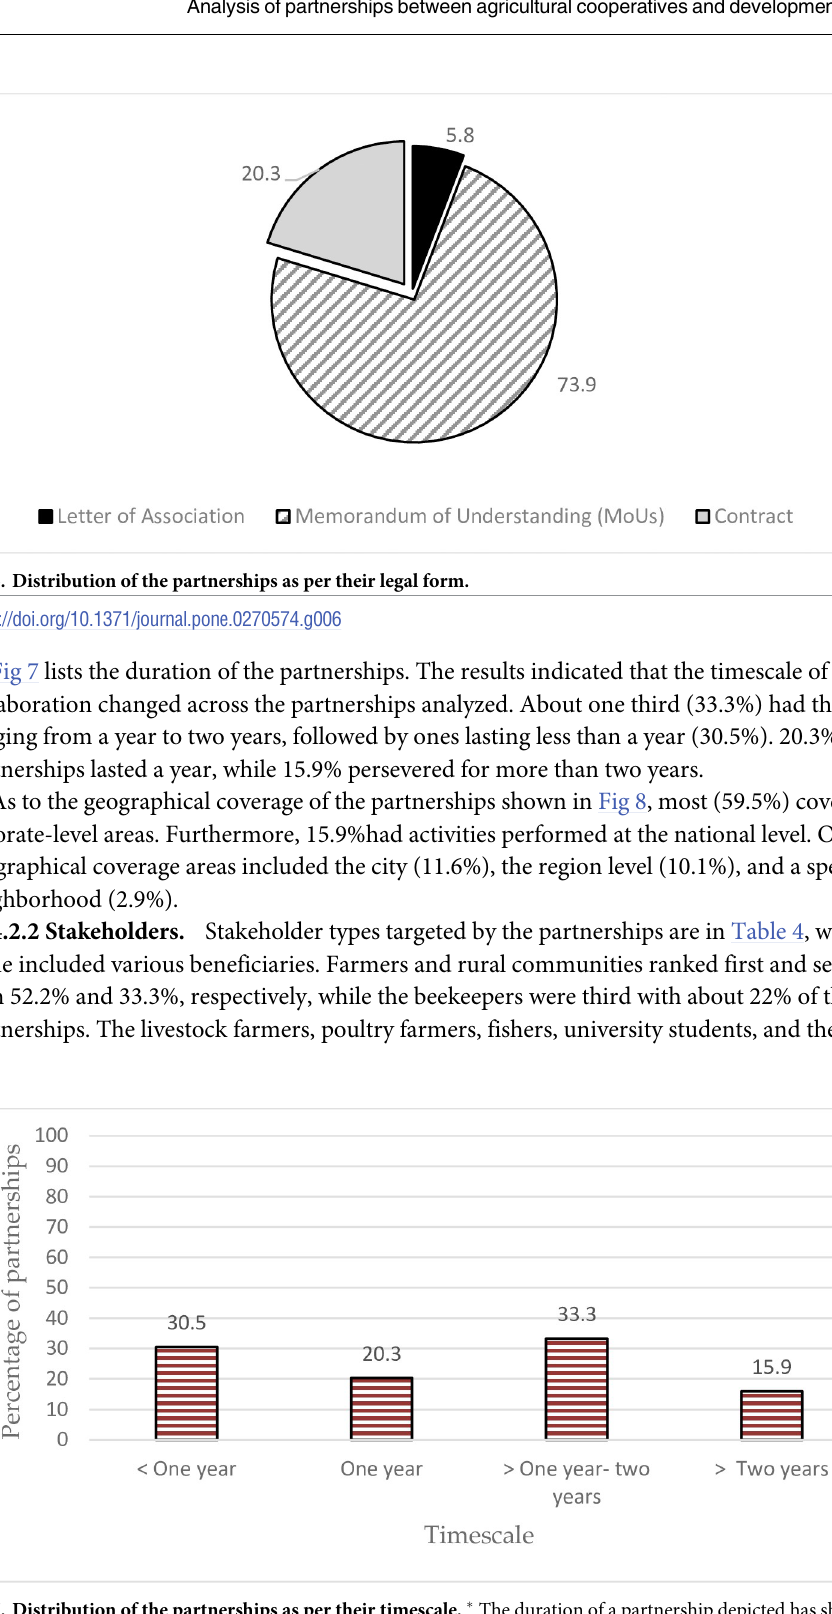
Fig 7. Distribution of the partnerships as per their timescale. � The duration of a partnership depicted has shown the term mentioned at the beginning of the collaboration. The extension periods of some are not available.